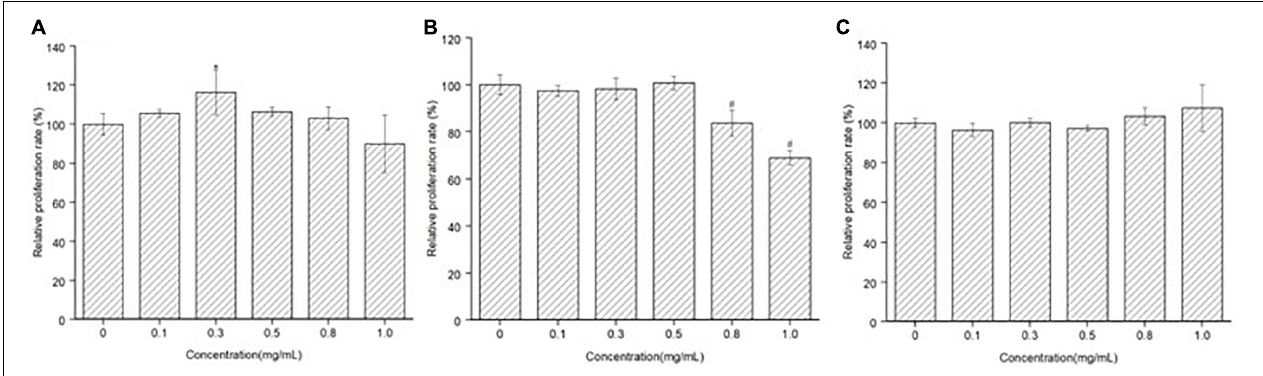
FIGURE 2 | Effect of peptide MGF, CF, and MF on MC3T3-E1 cells’ proliferation. (A) Group treated with MGF for 72 h. (B) Group treated with CF for 72 h. (C) Group treated with MF for 72 h. ∗ P < 0.05, # P < 0.01.